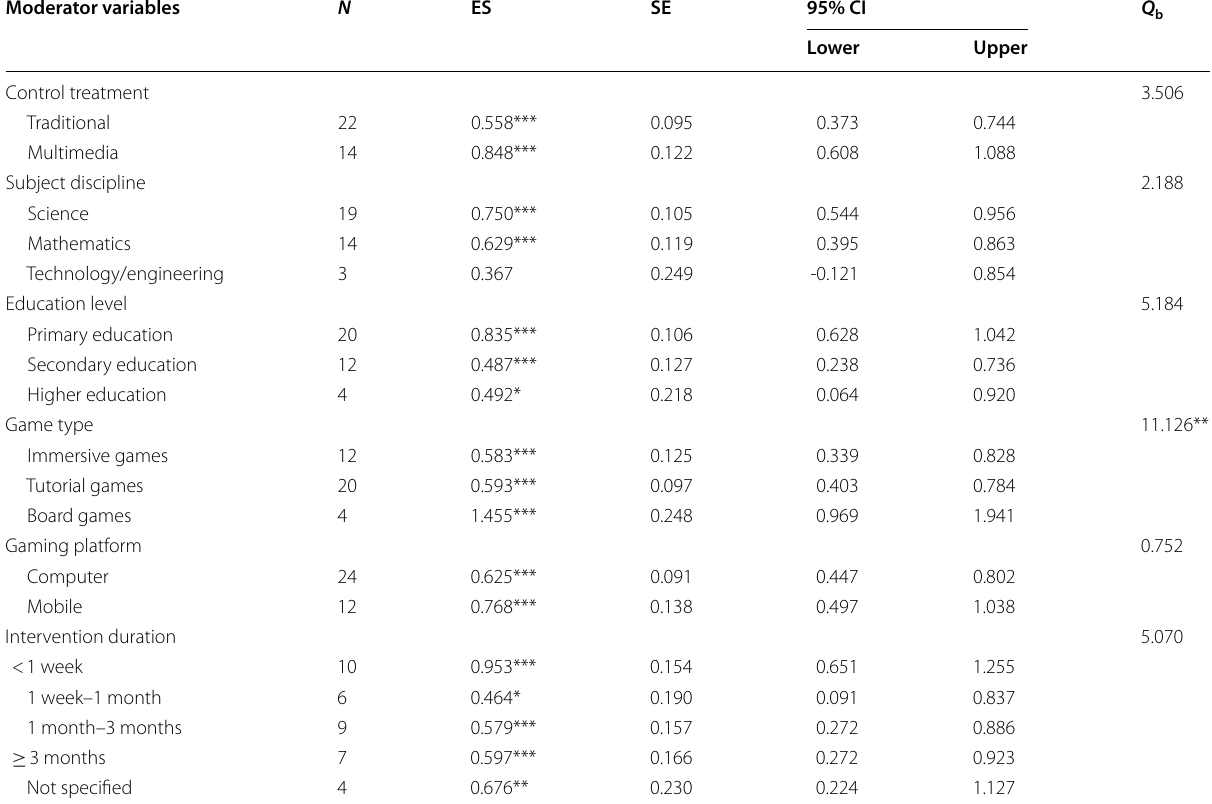
N , the number of effect sizes; ES, effect size; SE, standard error; Q b , Q value of the heterogeneity test between the subgroups; CI, confidence interval; * p < 0.05; ** p < 0.01; *** p <